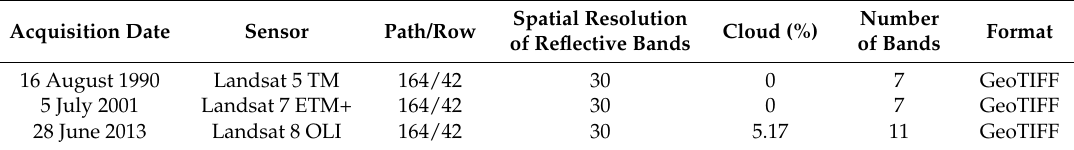
Table 1. Characteristics of the Landsat datasets used in the study.